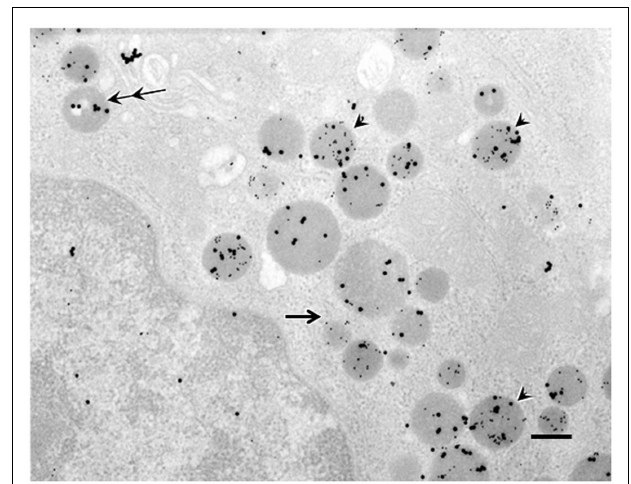
FIGURE 2 | Double immunogold labeling in ghrelin-producing cells in the stomachs of control mice. Large particles of immunogold (20nm in diameter) or small particles of immunogold (10nm in diameter) demonstrated immunoreactivity for C8-ghrelin (ir-C8-ghrelin) or C10-ghrelin (ir-C10-ghrelin), respectively. Over 70% of secretory granules in ghrelin-producing cells exhibited both ir-C8-ghrelin and ir-C10-ghrelin (arrowheads). Occasionally (10–20% of the secretory granules), there appeared granules stained only for ir-C8-ghrelin reflected by large particles (double arrows) or ir-C10-ghrelin reflected by small particles of immunogold (single arrow) in ghrelin-producing cells. Scale bar represents 200nm.